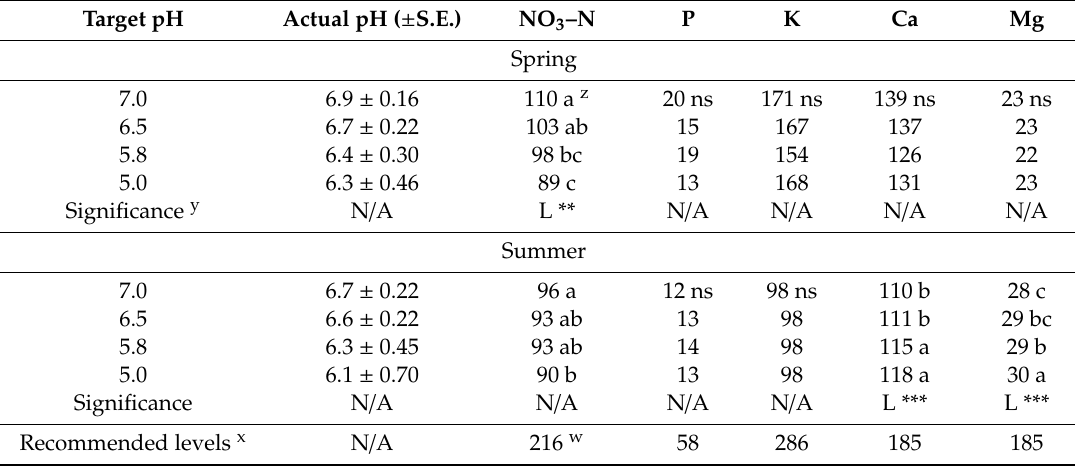
Table 4. End-of-season macronutrient analysis (mg · L –1 ) of aquaponic irrigation water at four target pH treatments.